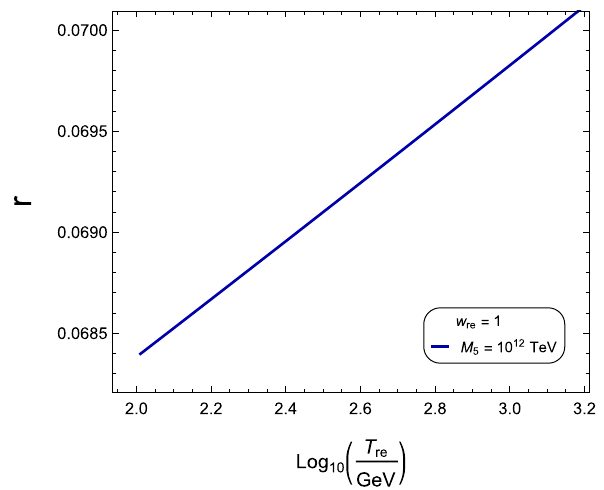
Fig. 5 Plot of the tensor-to-scalar ratio r against the reheating temper- ature for Natural inflation for w re = 1 and α = 0 . 0393 when using M 5 = 10 12 TeV